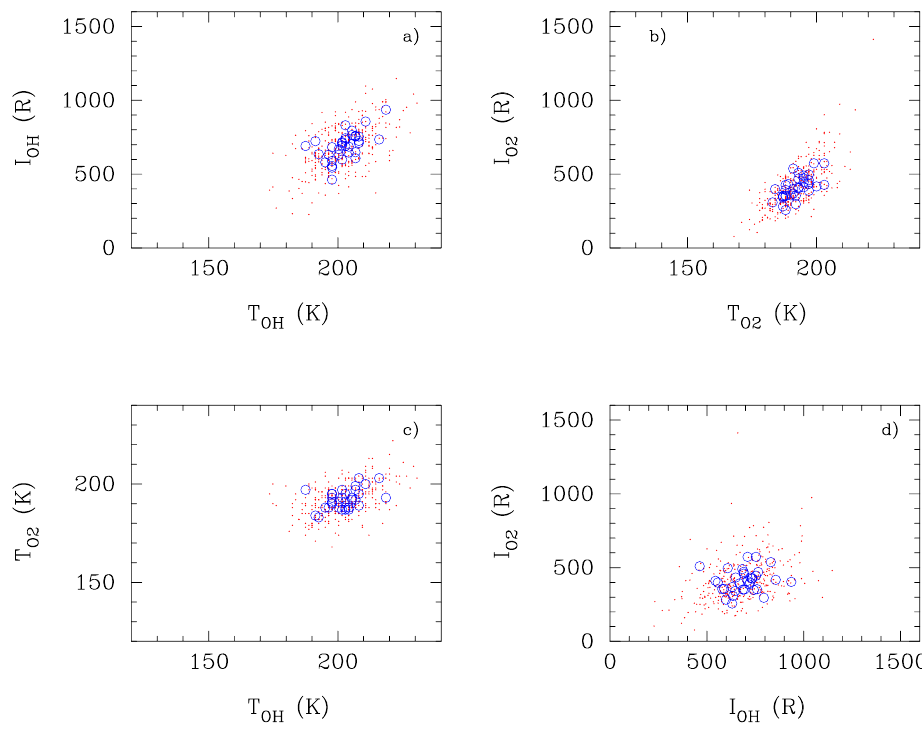
Fig. 5. Relation among emission rates and rotational temperatures. Point: the average value for midnight Circle: the average value for the month. (a) I OH versus T OH . (b) I O